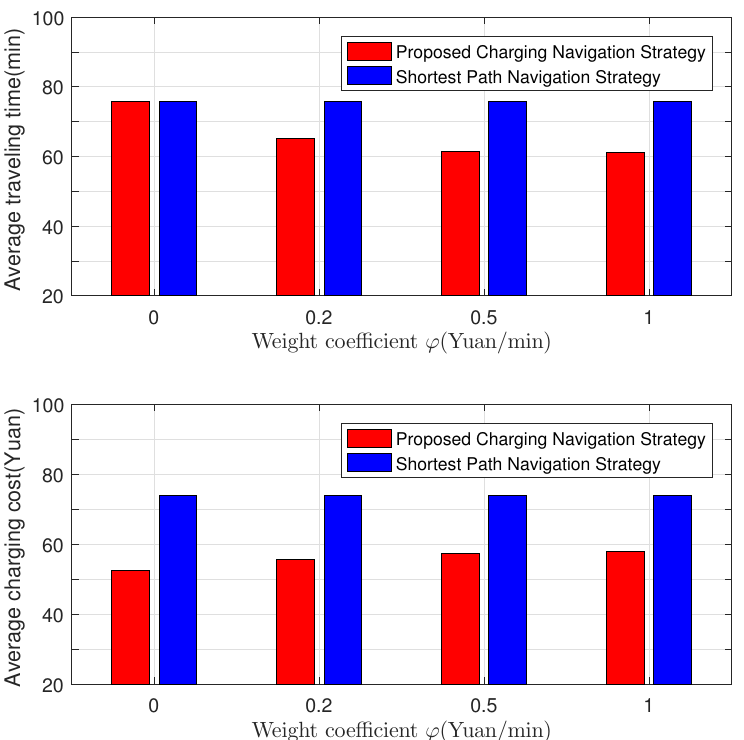
Figure 12. Comparison of traveling time and charging cost with different weight coefficients by two navigation